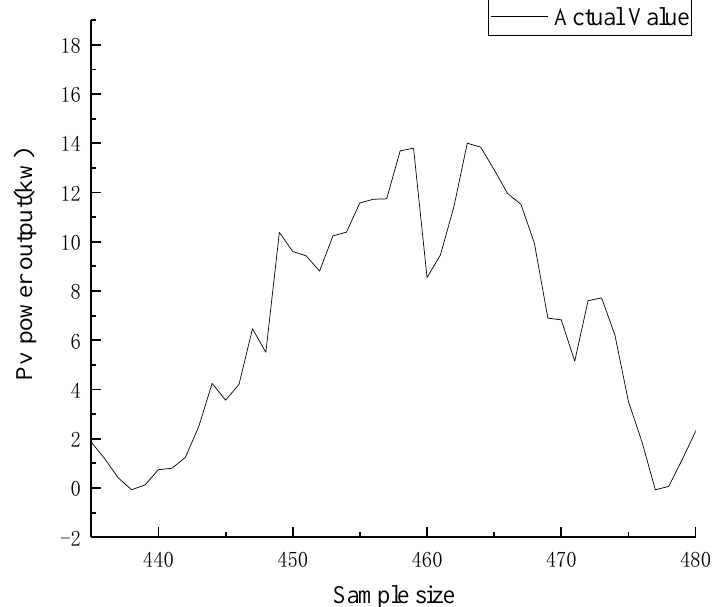
Figure 2. Non-stationary period of photovoltaic output.